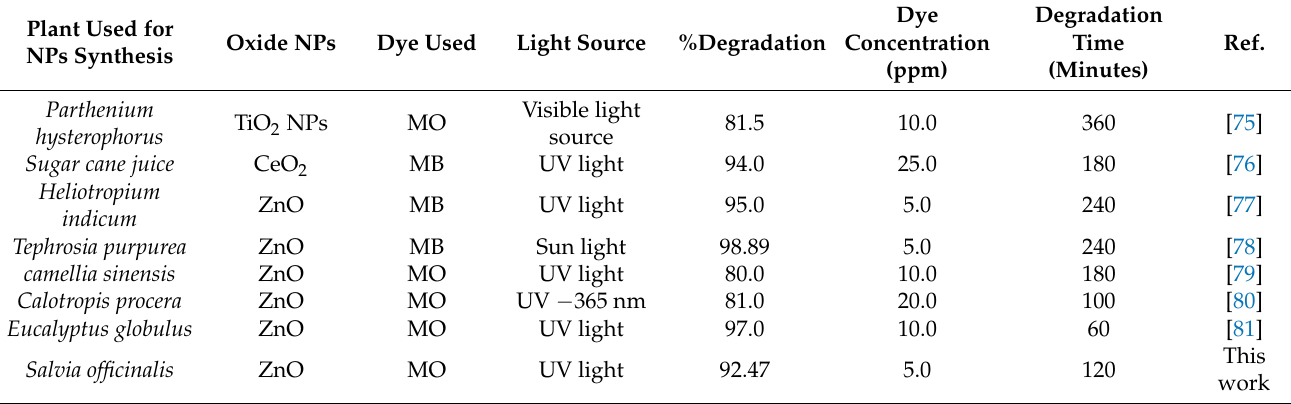
Table 2. Comparison of photocatalytic degradation efficiency of ZnO